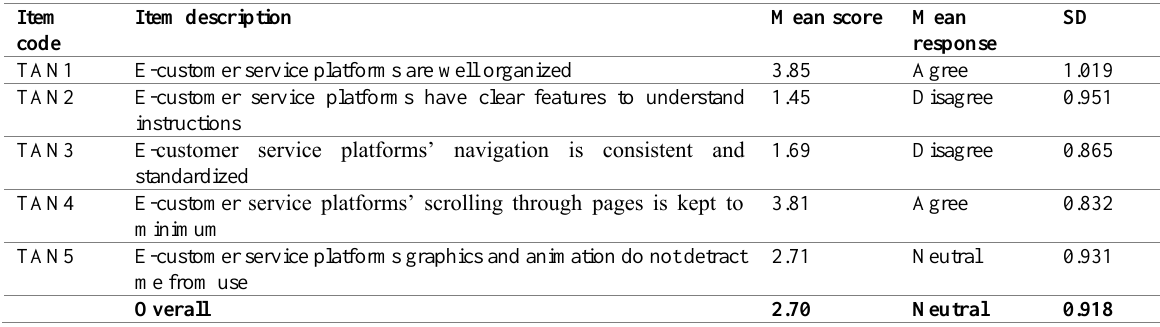
Table 7: Descriptive Statistics for